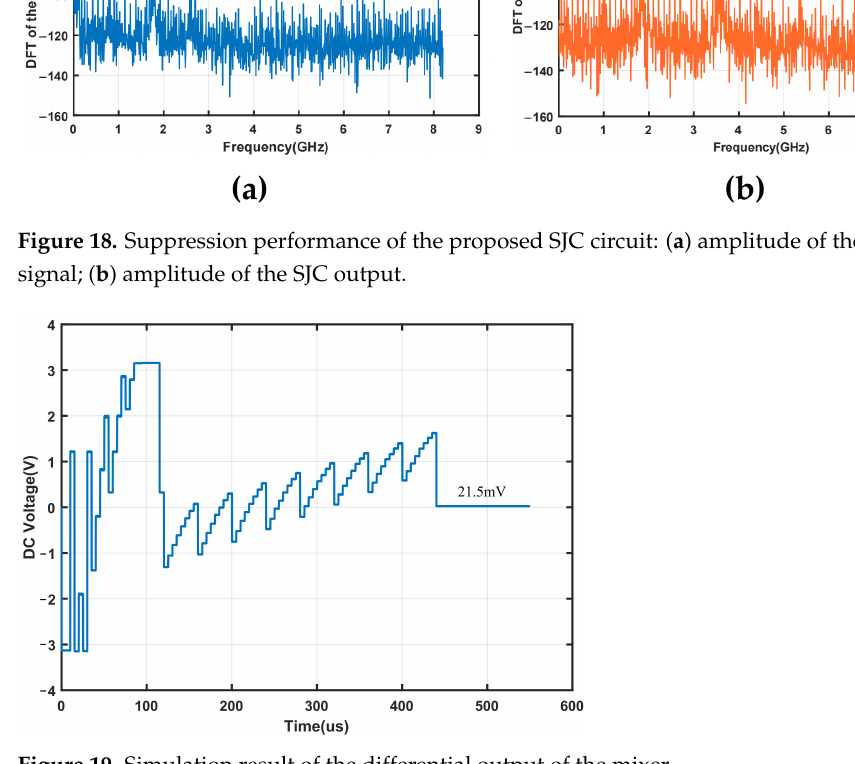
Figure 19. Simulation result of the differential output of the